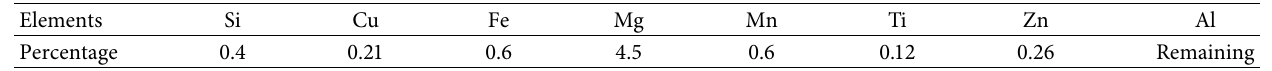
Table 1: Composition of AA5086.